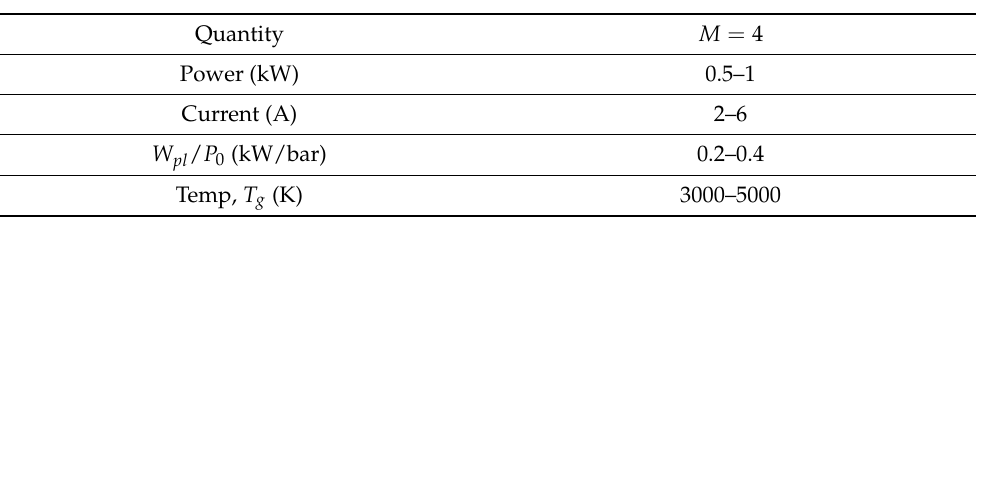
Table 2. Key plasma filament parameters in Mach 4